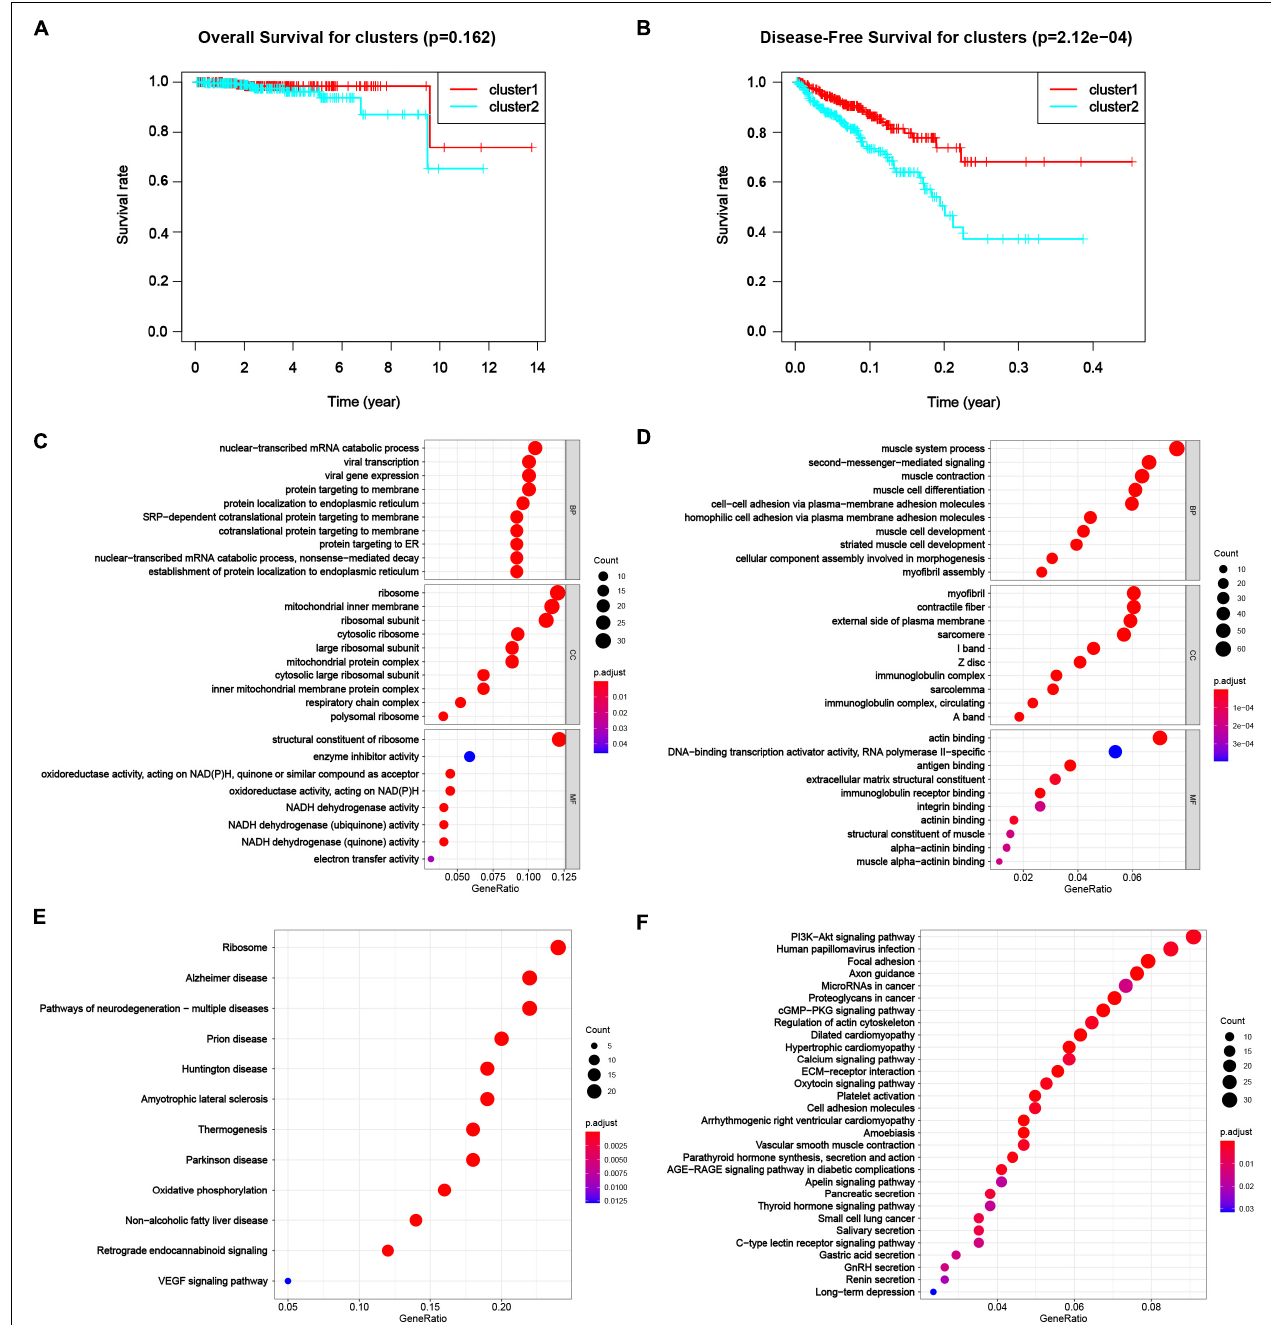
FIGURE 4 | Differential characteristics of total transcriptomic profile in TCGA-PRAD tumorous cohort between clusters. (A) Kaplan–Meier overall survival (OS) curves for patients in distinct clusters ( p = 0.162). (B) Kaplan–Meier disease-free survival (OS) curves for patients in distinct clusters ( p < 0.001). (C,D) Gene Ontology (GO) analysis of differentially expressed genes (DEGs) between clusters. Left, up-regulated DEGs; right, down-regulated DEGs. BP, biological process; CC, cellular component; MF, molecular function. (E,F) Kyoto Encyclopedia Genes and Genomes (KEGG) analysis of DEGs between clusters. Left, up-regulated DEGs; right, down-regulated